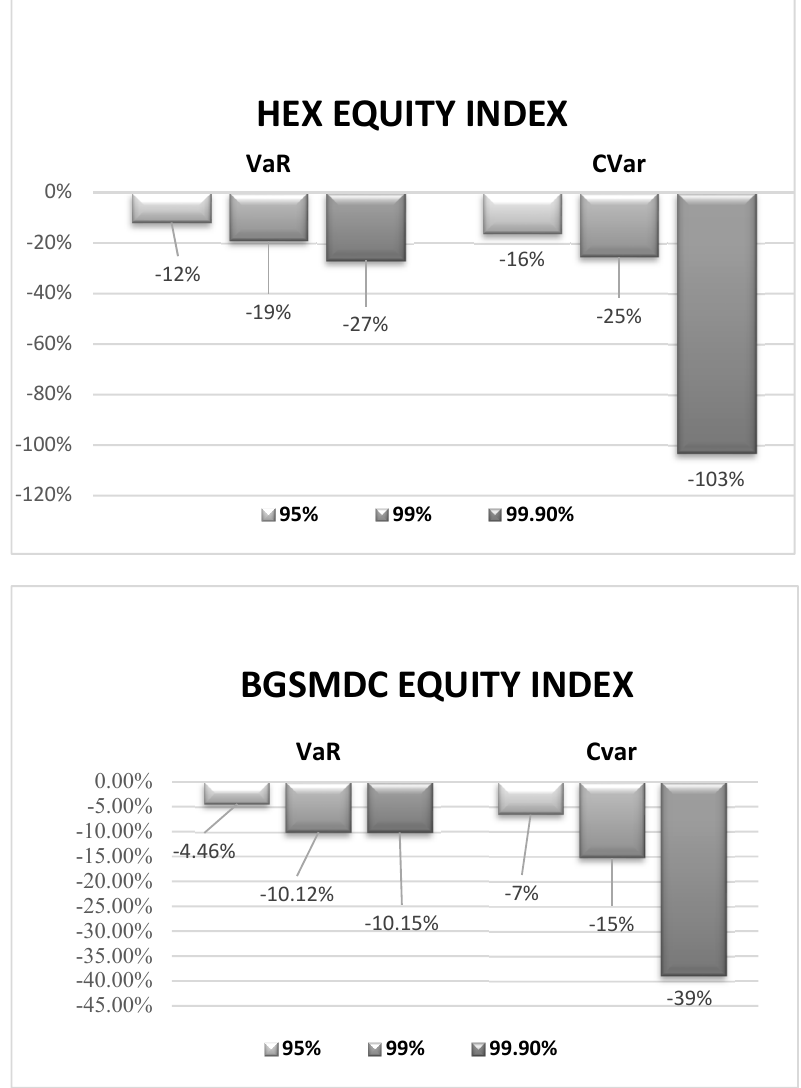
Figure 1. VaR versus CVaR for HEX and BGSMDC Equity Asset Index. Source: authors.